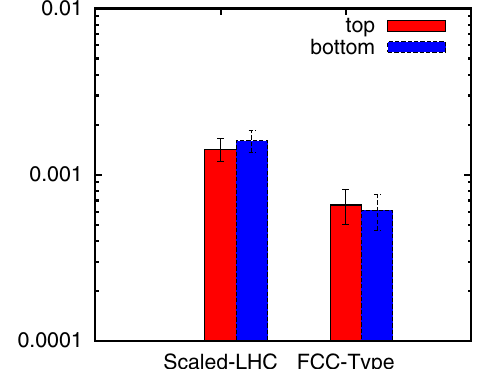
FIG. 10. Fraction of photons absorbed at the top and bottom of two proposed vacuum chambers for the HE-LHC, with a 95% confidence